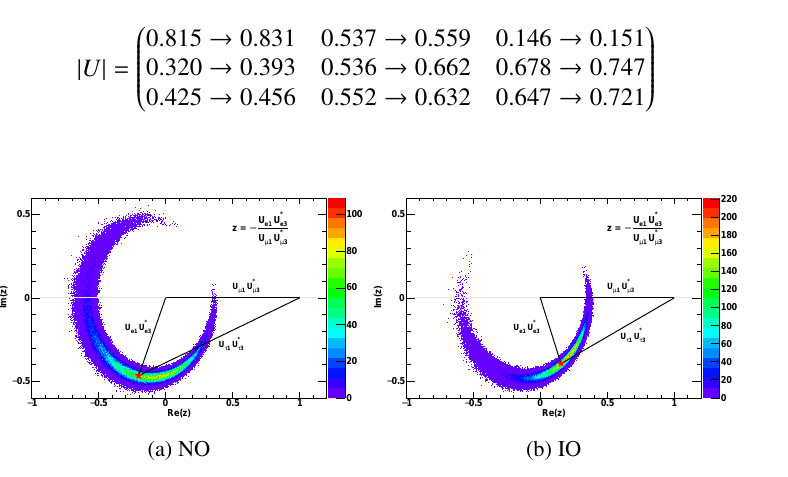
Figure 4.2: Plot of δ CP with the four oscillation parameters having 1 σ